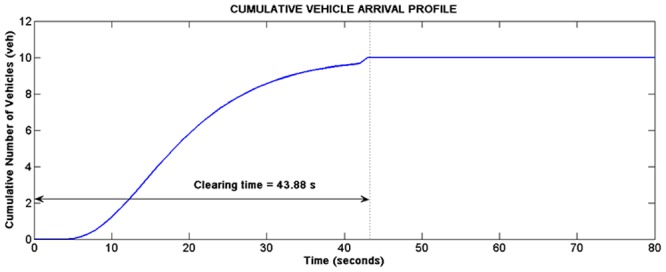
Arrival profile of platoon B.